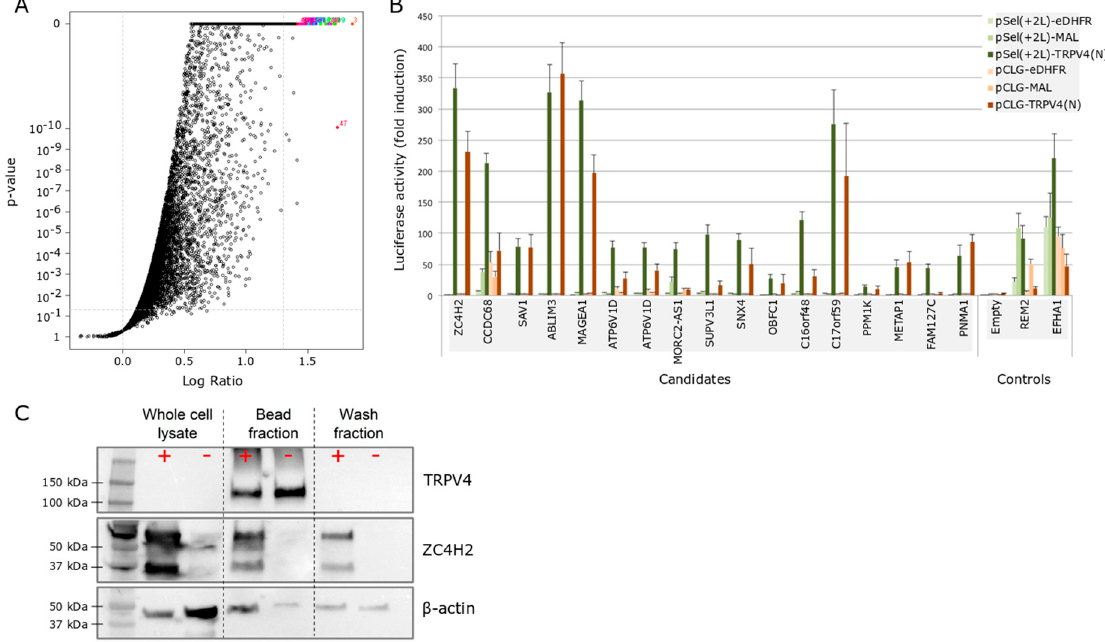
Figure 1. MAPPIT and co-IP show an interaction of ZC4H2 and TRPV4. ( A ) Volcano plot of the whole protein library tested in an initial MAPPIT screen, with the p -value in the function of the MAPPIT signal. Interesting ‘hits’ are located at the upper right corner. ( B ) Luciferase read-out of the top 17 hits identified in the MAPPIT screening. Baits cloned in the pSEL and pCLG vector background were tested in parallel and contained either the human N-terminus TRPV4 or an irrelevant protein (E. coli dihydrofolate reductase (eDHFR) or myelin and lymphocyte protein (MAL)). Additionally, an empty prey plasmid was used as a negative control. Positive assay controls are RRAD and GEM Like GTPase 2 (REM2) and EF-hand domain family member A1 (EFHA1), two proteins known to bind the cytokine receptor complex bait independently. ( C ) Human embryonic kidney (HEK)-293T cells were co-transfected with TRPV4-GFP and ZC4H2-mCherry ( + ) or TRPV4-GFP and mCherry ( − ). SDS-PAGE was performed for three conditions: the whole cell lysate, the fraction bound to GFP-Trap ® beads, and the unbound (wash) fraction. Staining was done using specific antibodies for human TRPV4 (98 kDa), ZC4H2 (26 kDa), and β -actin (42 kDa). Note that in these experiments, TRPV4 and ZC4H2 are coupled to green fluorescent protein (GFP) and mCherry, respectively, which increases the molecular weights of the detected proteins by 27 kDa. In two independent experiments, we confirmed that there was negligible binding of mCherry and ZCH2-mCherry to the GFP-Trap ®